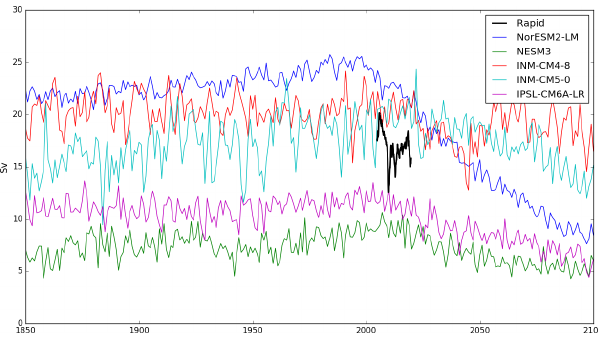
Figure A6. AMOC strength at 1000m (from v (velocities) com- pared to rapid array (annual mean Sv)) at 26 ◦ N. AMOC data are from Menary et al. (2020).